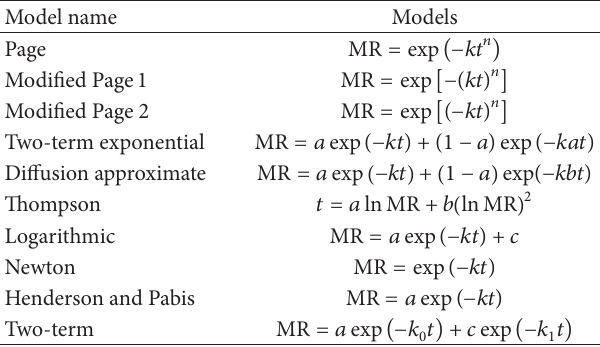
Table 1: Mathematical models used to describe the drying charac- teristic of fish